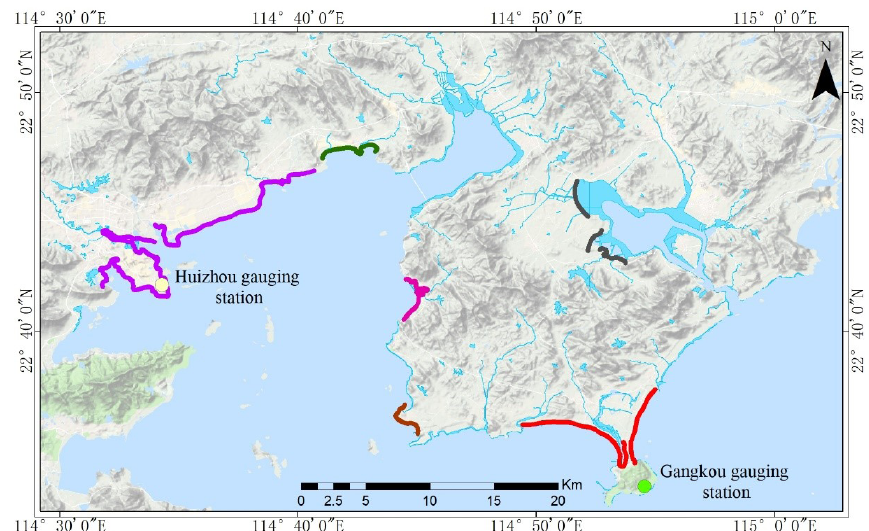
Figure 3. The map of Storm Surge Barriers such as dikes and levees along the coastline of Huizhou over the study area, which are marked by the colored lines. The two stations including Huizhou gauging station and Gangkou gauging station measure the water levels in the study area, which are indicated by the lemon chiffon dot and the green dot, respectively. The map was made using the ArcGIS 10.5 software based on the terrain base map layer, which was obtained from © Google Maps (map data © 2019 Google).